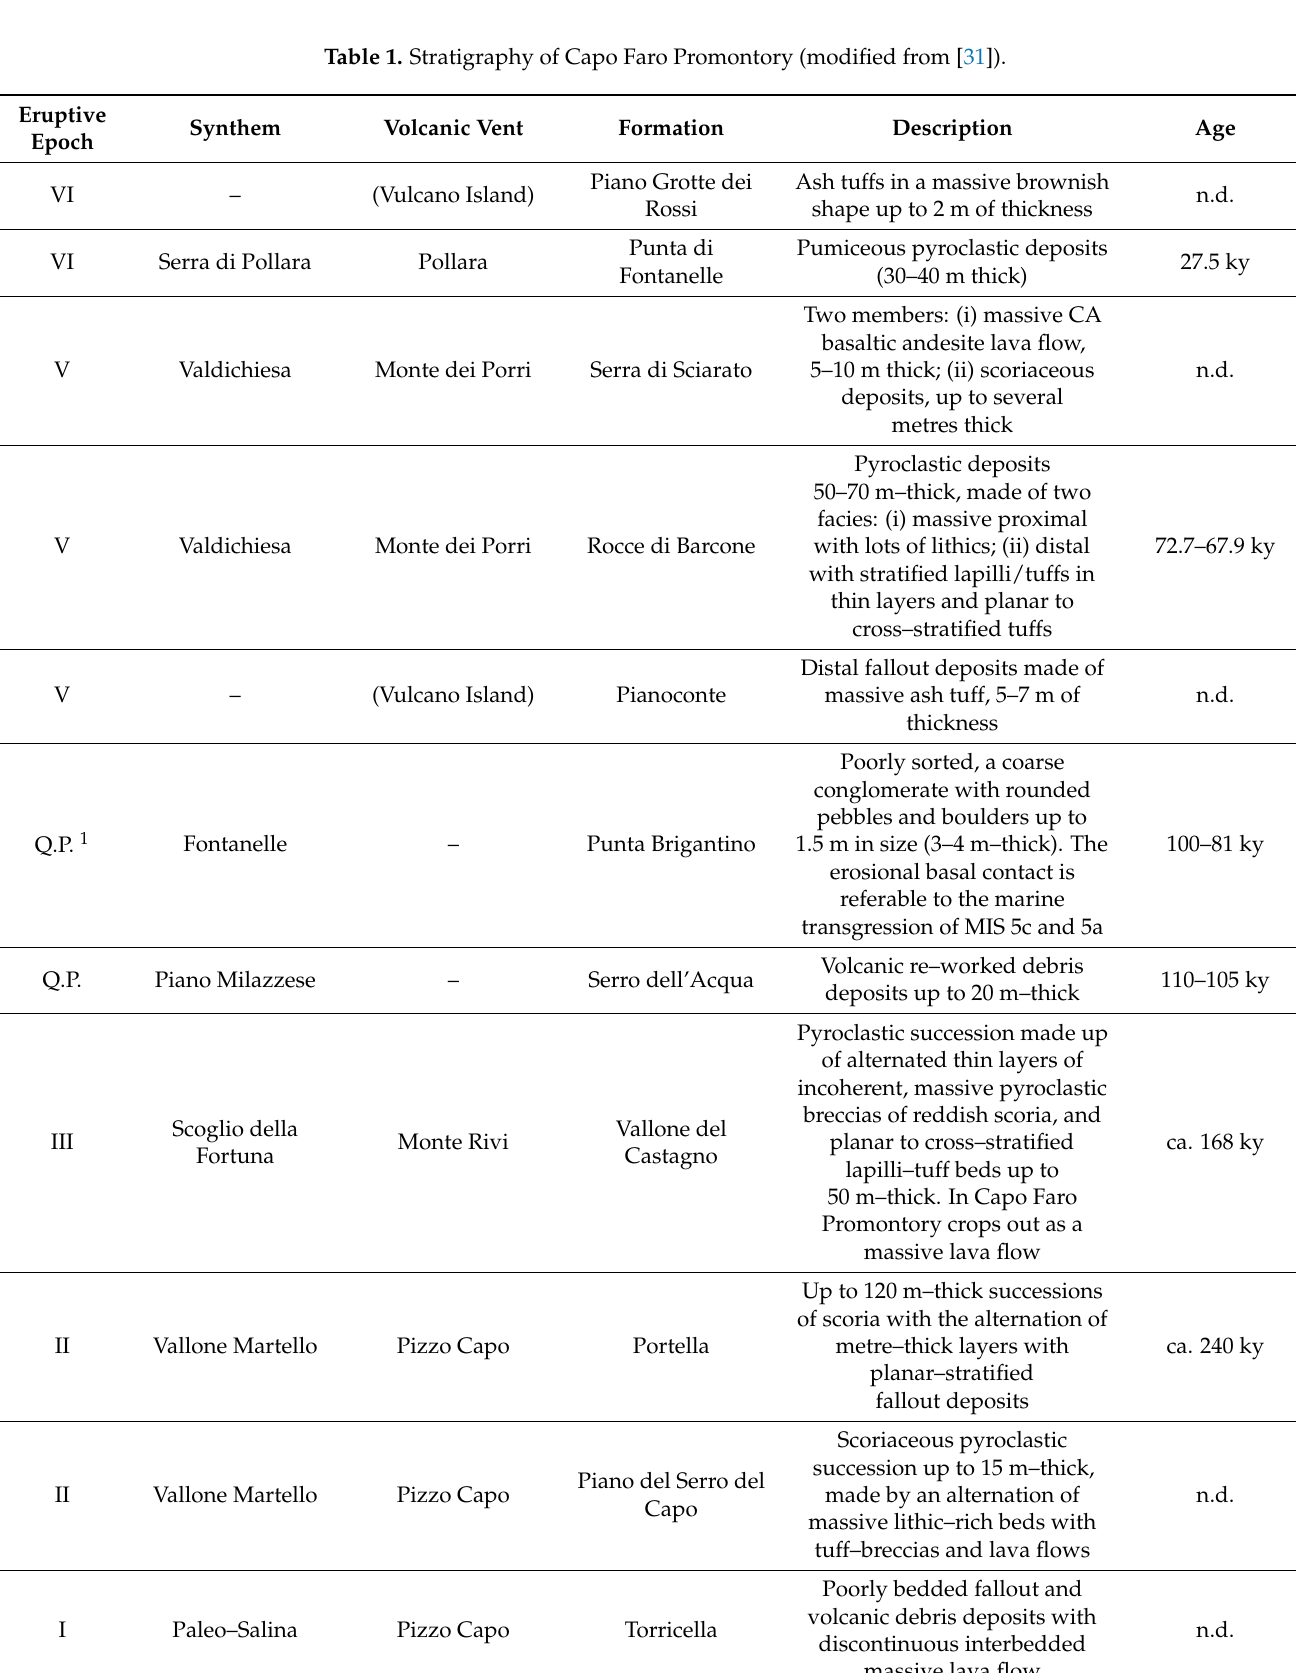
Table 1. Stratigraphy of Capo Faro Promontory (modified from